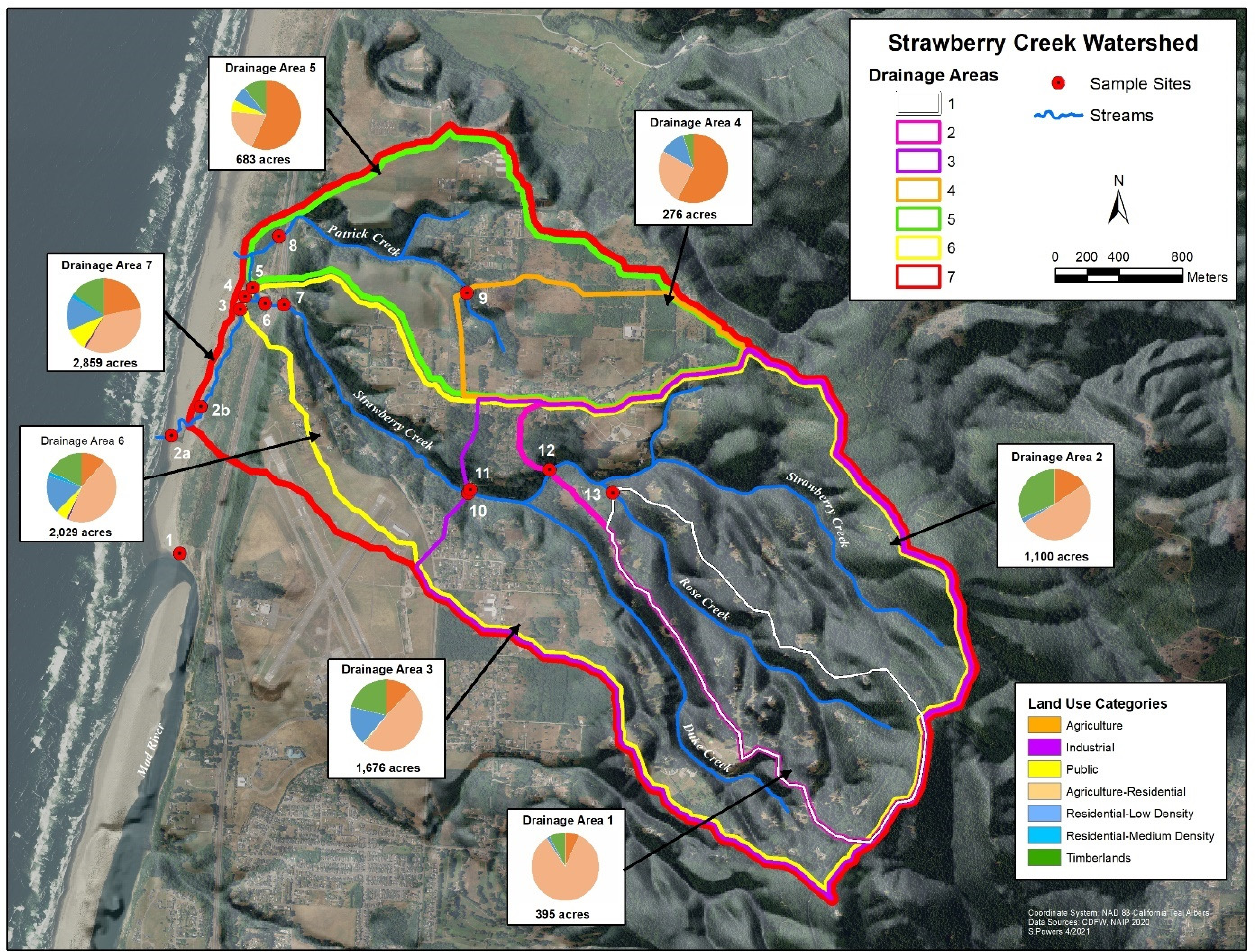
Figure 1. GIS map of the study area showing the 14 collection sites along Clam Beach, Strawberry Creek, Patrick Creek, and Rose Creek used in this study. A description of the seven drainage areas, land use composition, and relative size is shown. County of Humboldt GIS.